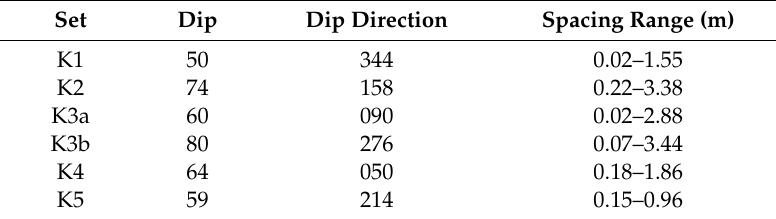
Table 2. Average orientation and spacing range of the main discontinuities sets obtained from traditional surveys.